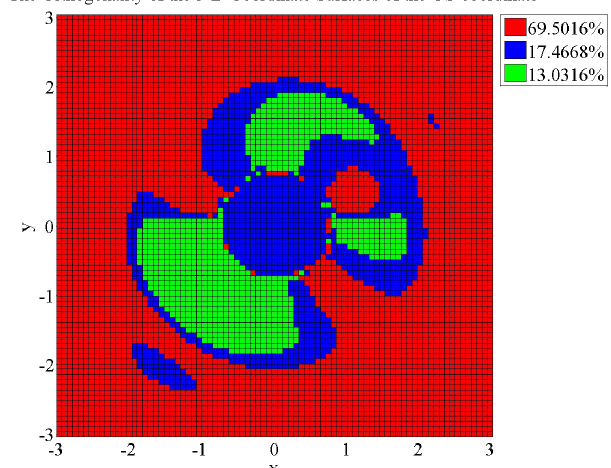
Figure 5. The orthogonality of the points on the coordinate surfaces of the OS coordinate at the same height. Red represents the angle ranges from 80–100 ◦ , blue is for 70–80 ◦ or 100–110 ◦ , green is for 60–70 ◦ or 110–120 ◦